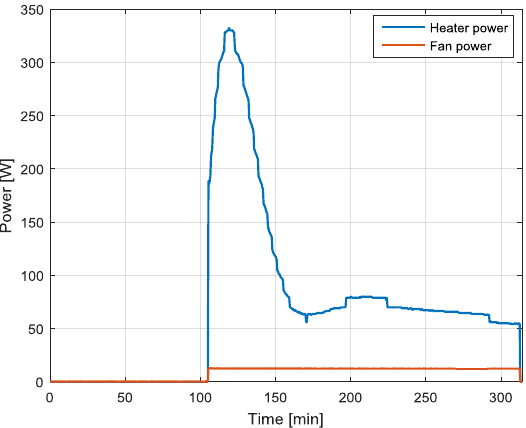
Figure 5. Variation of heater and fan power with time during Test 1.